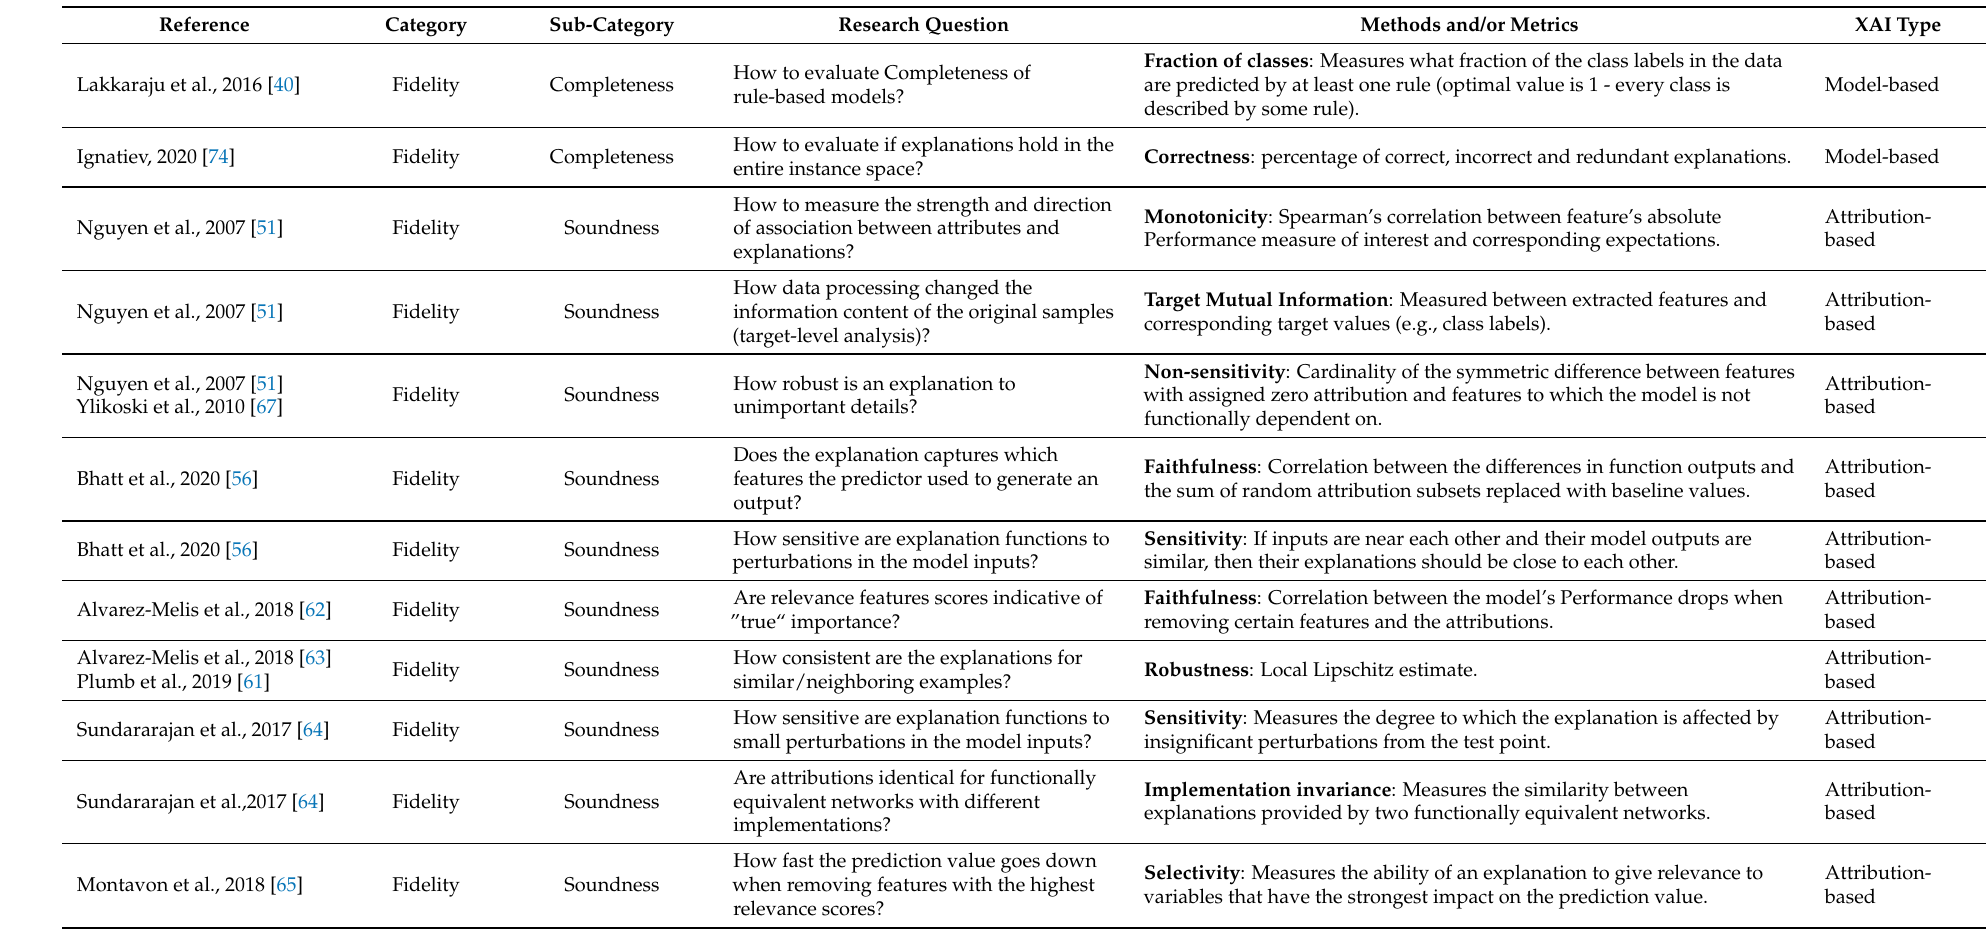
Table 4. Computer-centred evaluation methods for machine learning